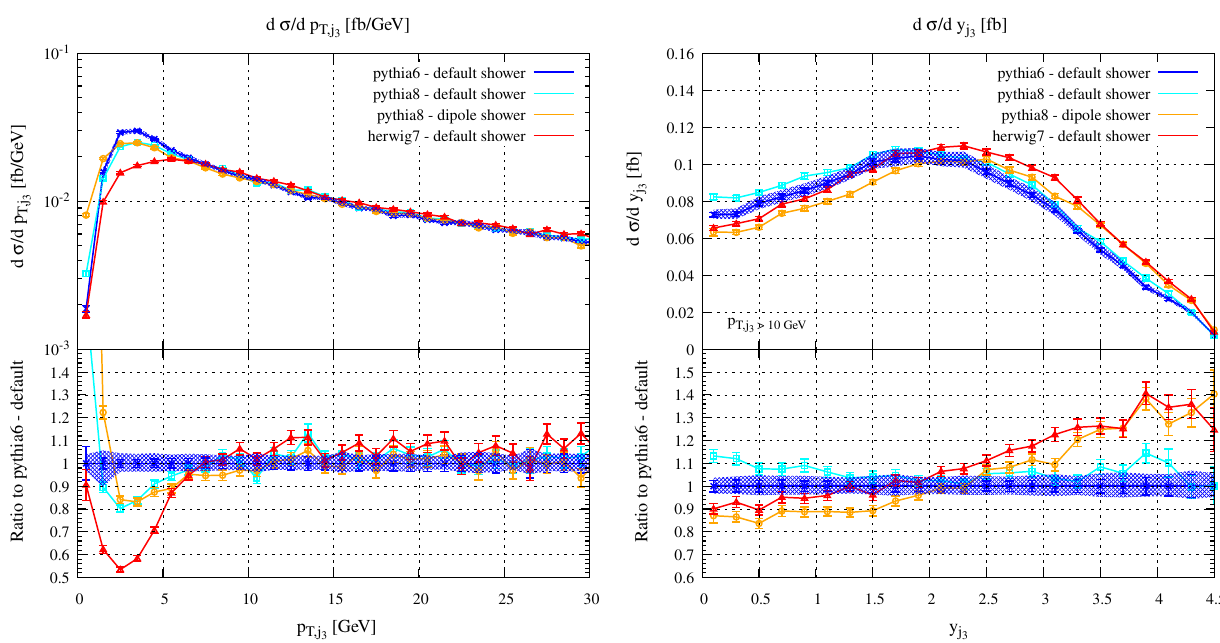
Fig. 8 Transverse-momentum (left) and rapidity (right) distributions of the third jet in the ATLAS-loose scenario. In the lower panels the ratio of the respective distribution to the PYTHIA6 reference result is